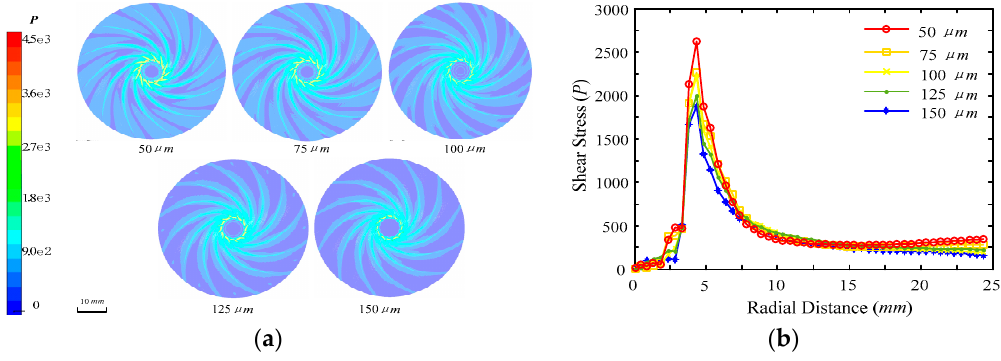
Figure 6. Distribution of shear stress on the workpiece: ( a ) distribution of shear stress under different fluid film thickness and ( b ) average shear stress along the radial distance of the disc polishing tool.